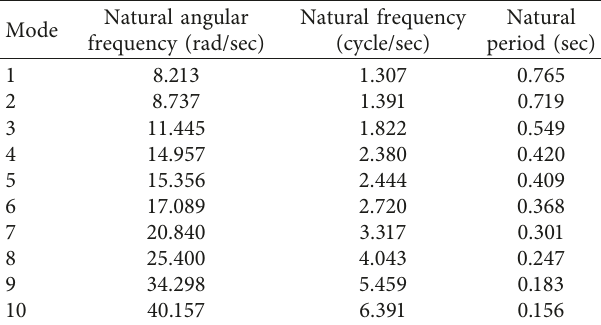
Figure 10: Finite element division of bridge elements. Table 2: First 10 natural frequencies and natural periods of the bridge